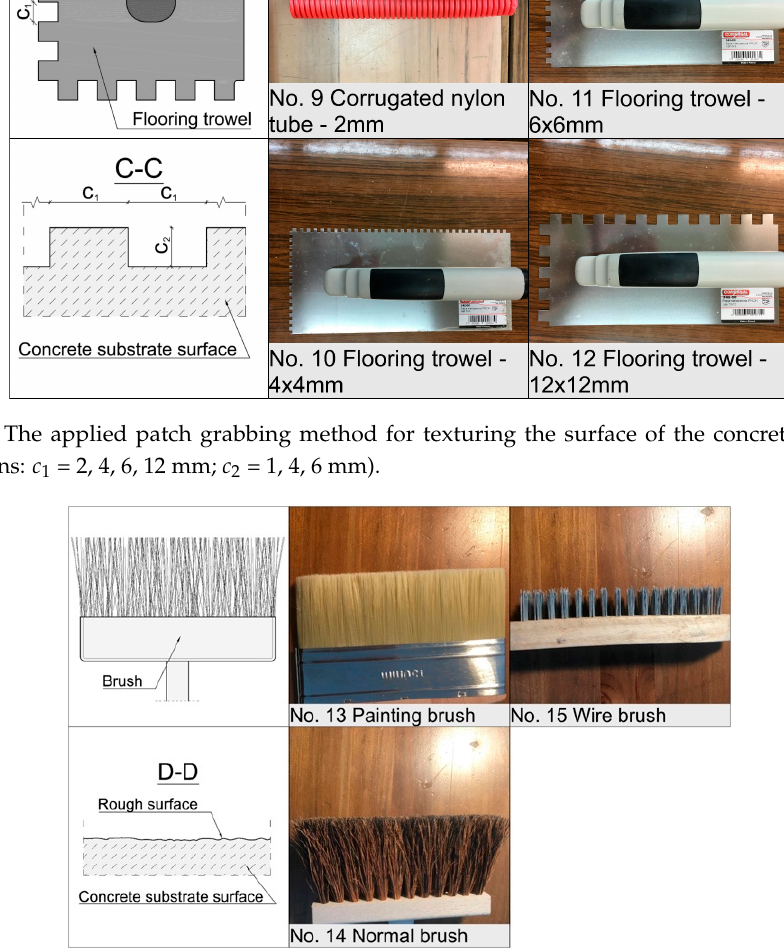
Figure 4. The applied brushing method for texturing the surface of the concrete substrate.